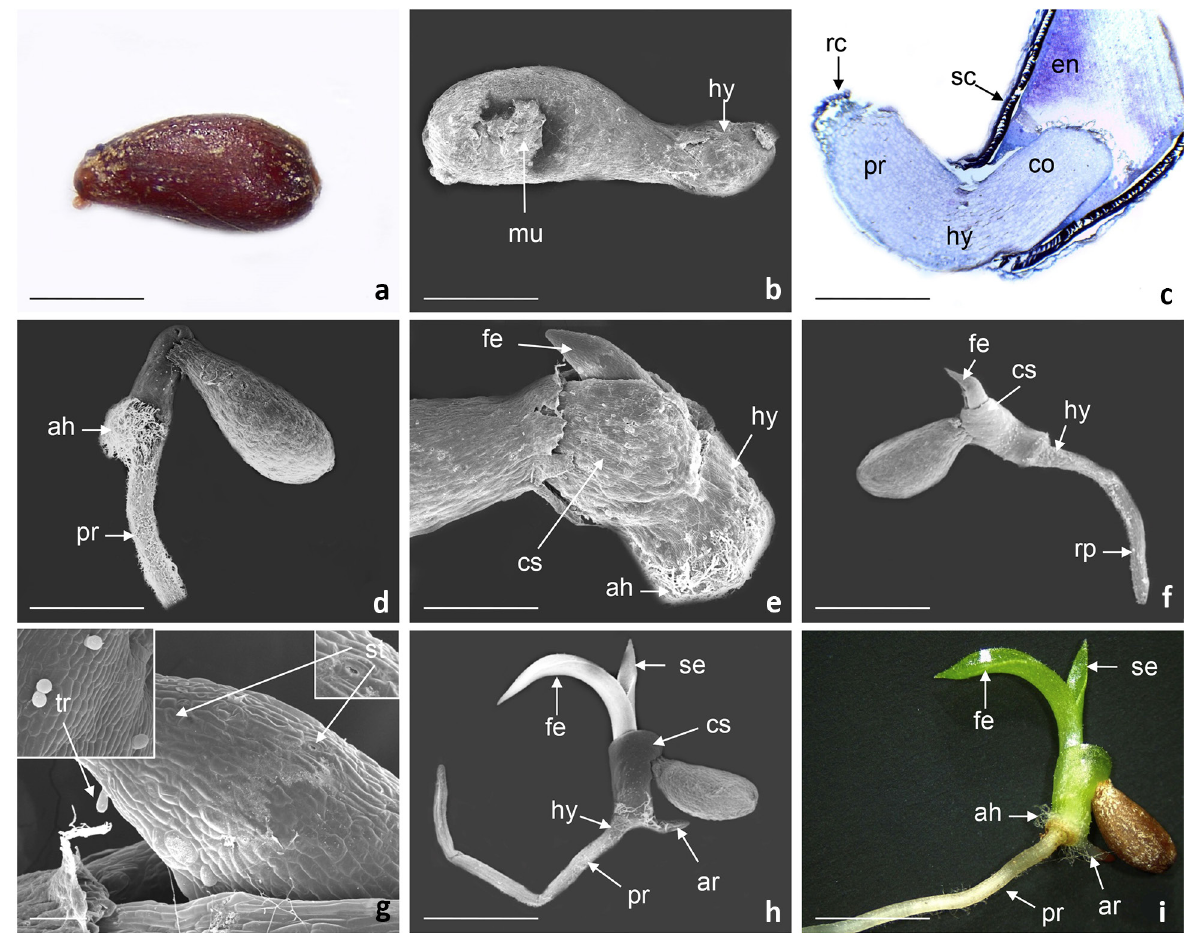
Figure 3. Seed morphology and post-seminal development of Hohenbergia castellanosii . a) Mature seed and surrounding mucilaginous substance; b- i) Phases of post-seminal development observed by light microscopy (c, i) and scanning electron microscopy (b, d, e, f, g, h). b, c) Emergence of the primary root and elongation of the hypocotyl region by the rupture of the seed coat. c) Cylindrical haustorial cotyledon inside the seed coat in contact with the endosperm and root cap around the well-developed cylindrical primary root. d) Numerous absorbent hairs on the root collar and base of the hypocotyl, as well as on the primary root. e- g) On day 8, the emergence was noted of a leafy cupuliform cotyledon sheath and the first eophyll, with the presence of glandular trichomes. h, i) On day 18, the hypocotyl and first eophyll were elongated and the second eophyll had emerged, along with the start of formation of adventitious roots. Overlapping cupuliform leaves forming rosettes were also observed. (ah) absorbent hairs; (ar) adventitious root; (co) cotyledon; (cs) cotyledon sheath; (en) endosperm; (fe) first eophyll; (hy) hypocotyl; (mu) mucilage; (pr) primary root; (rc) root cap; (sc) seed coat; (se) second eophyll; (st) stomata; (tr) trichome. Bars: a, c, i = 2 mm; b- h = 500 the form of flattended oval disks, inserted in The germination started on day 3 after septicidal capsule fruits, and have light brown moistening, with rupture of the seed coat and color, becoming darker in the region around emergence of the primary root covered by the root the embryo. They have a winged membranous cap (Figure 4b, c). There was positive geotropism appendage, enabling easy transport by wind or of the primary root and the cotyledon, along water (Figure 4a). with elongation of the s hypocotyl.